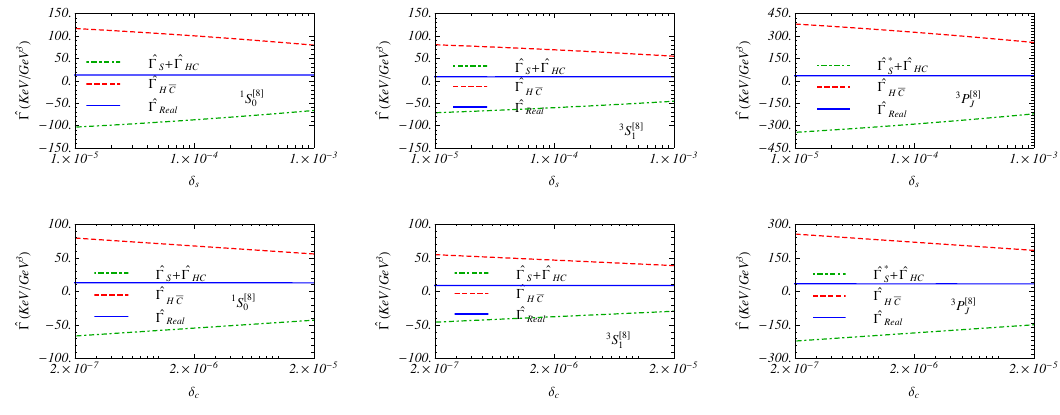
Figure 3 . Verifications of the independence on the soft ( δ s ) and collinear ( δ c ) cut-off